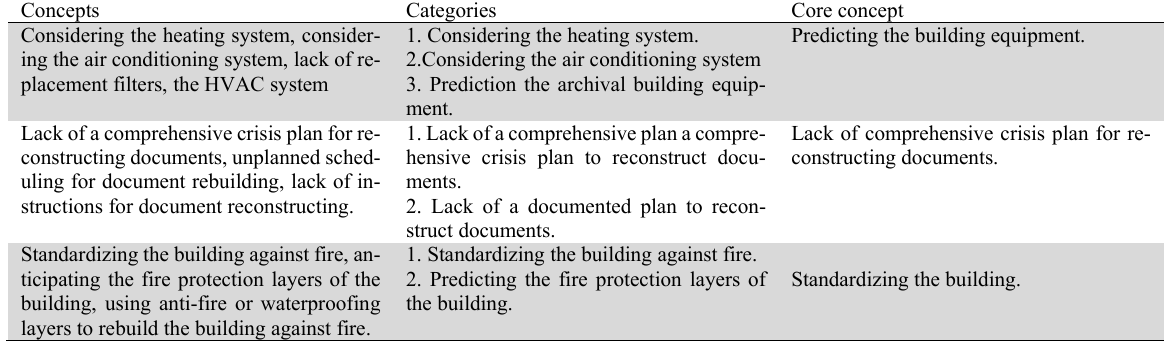
An example of conceptualizing sentences resulted from interviews and creating categories in pre-crisis situations